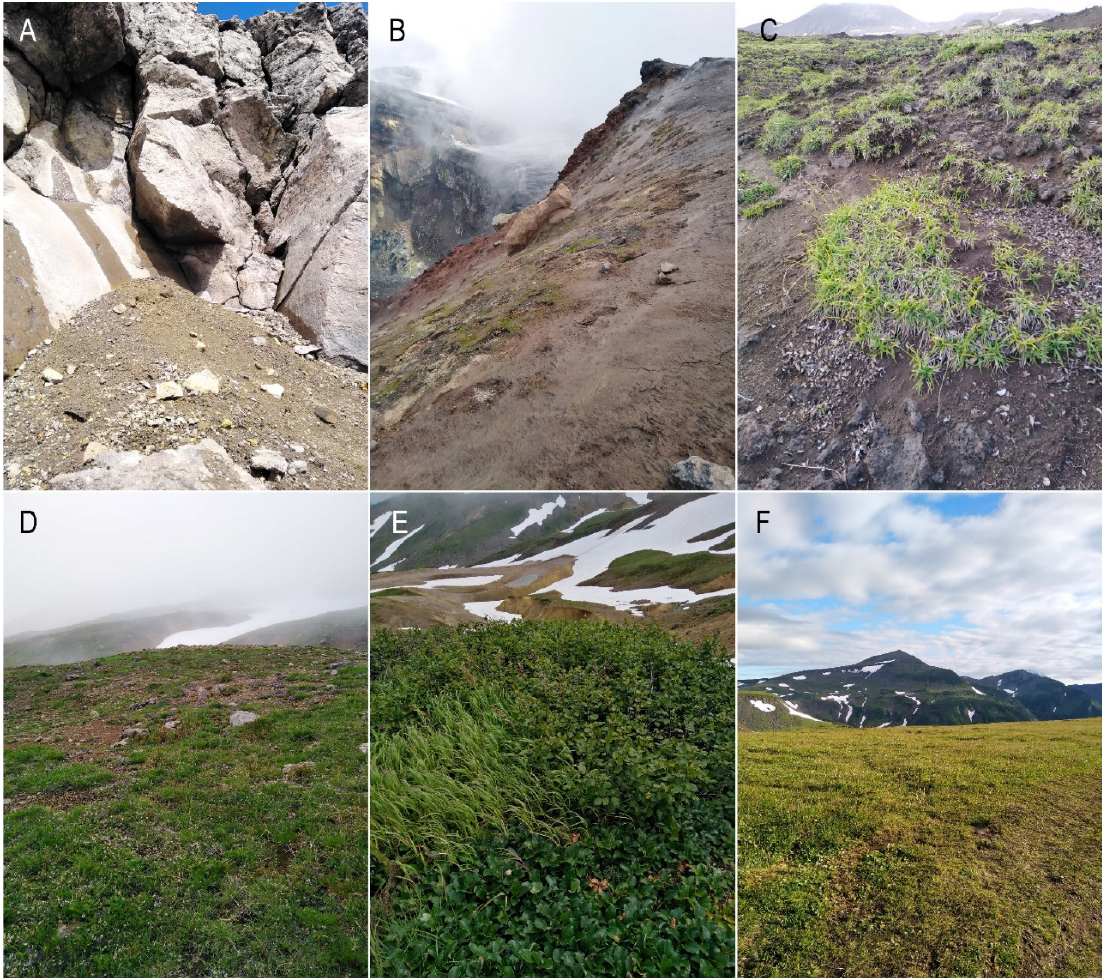
Figure 2. Study sites: ( A ) 102, scree of soil under the rock of Gorely volcano; ( B ) 103, thermal vapor outlet along the edge of the caldera on Gorely volcano; ( C ) 112, dead clump of sedge on a lava terrace on Gorely volcano; ( D ) 176, alpine meadow on Mutnovsky volcano; ( E ) 177, alder dwarf curtain on Mutnovsky volcano; ( F ) 182, alpine forb meadow on a volcanic plateau near the Mutnovskaya geo- thermal station on Mutnovsky volcano.